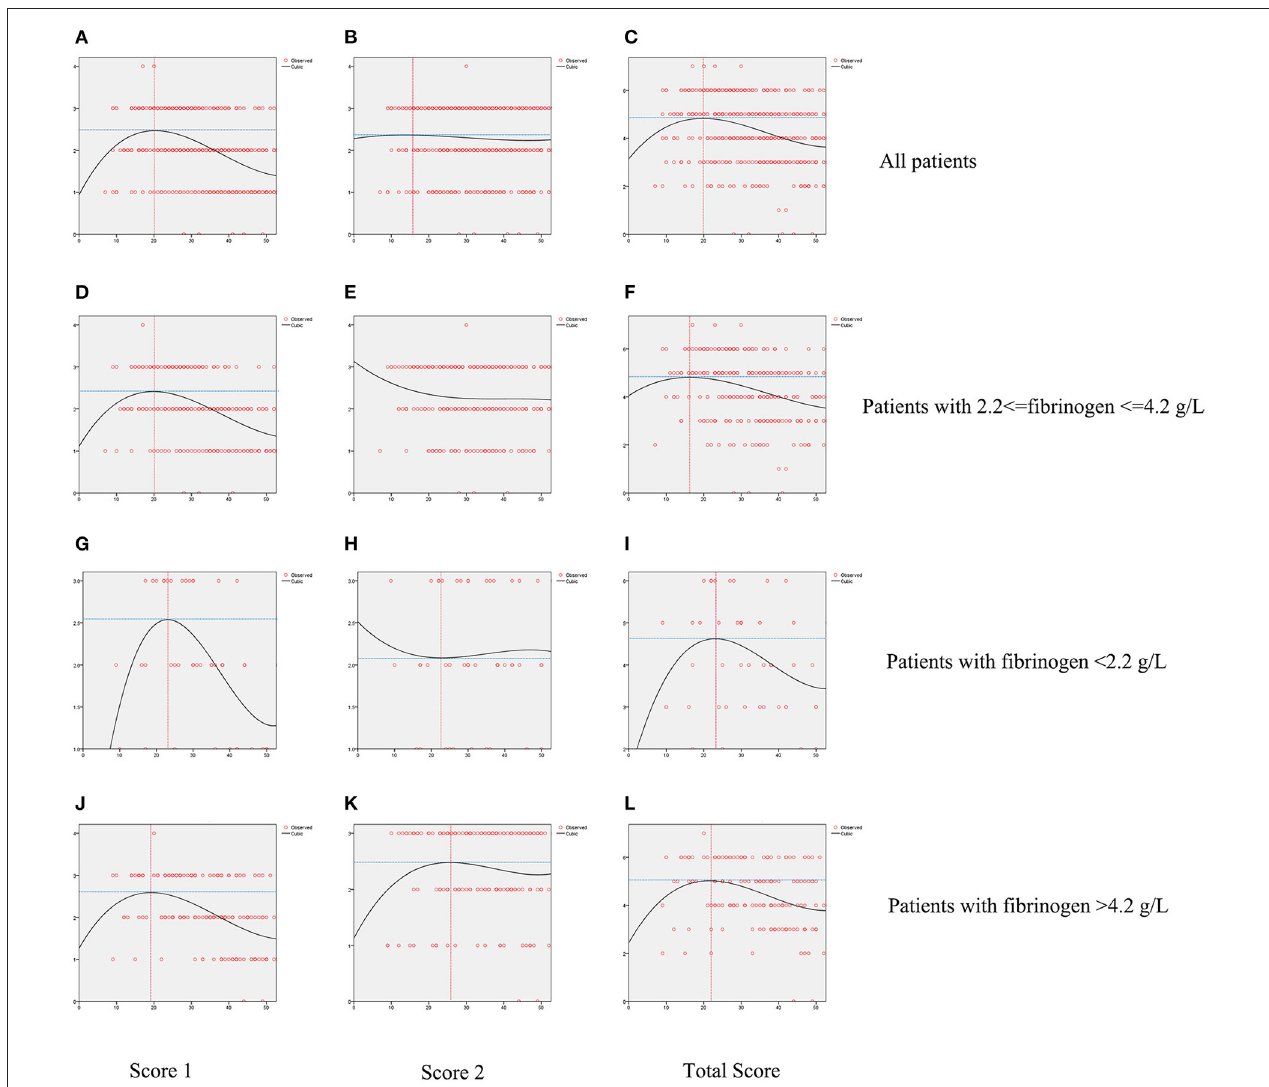
FIGURE 3 | Fitted curves of patients with COVID-19 divided by levels of fibrinogen based on CT score. Dynamic changes of Score 1 (A) , Score 2 (B) , Total Score (C) in all patients; dynamic changes of Score 1 (D) , Score 2 (E) , Total Score (F) in patients with fibrinogen between 2.2 and 4.2 g/L; dynamic changes of Score 1 (G) , Score 2 (H) , Total Score (I) in patients with fibrinogen < 2.2 g/L; dynamic changes of Score 1 (J) , Score 2 (K) , Total Score (L) in patients with fibrinogen over 4.2